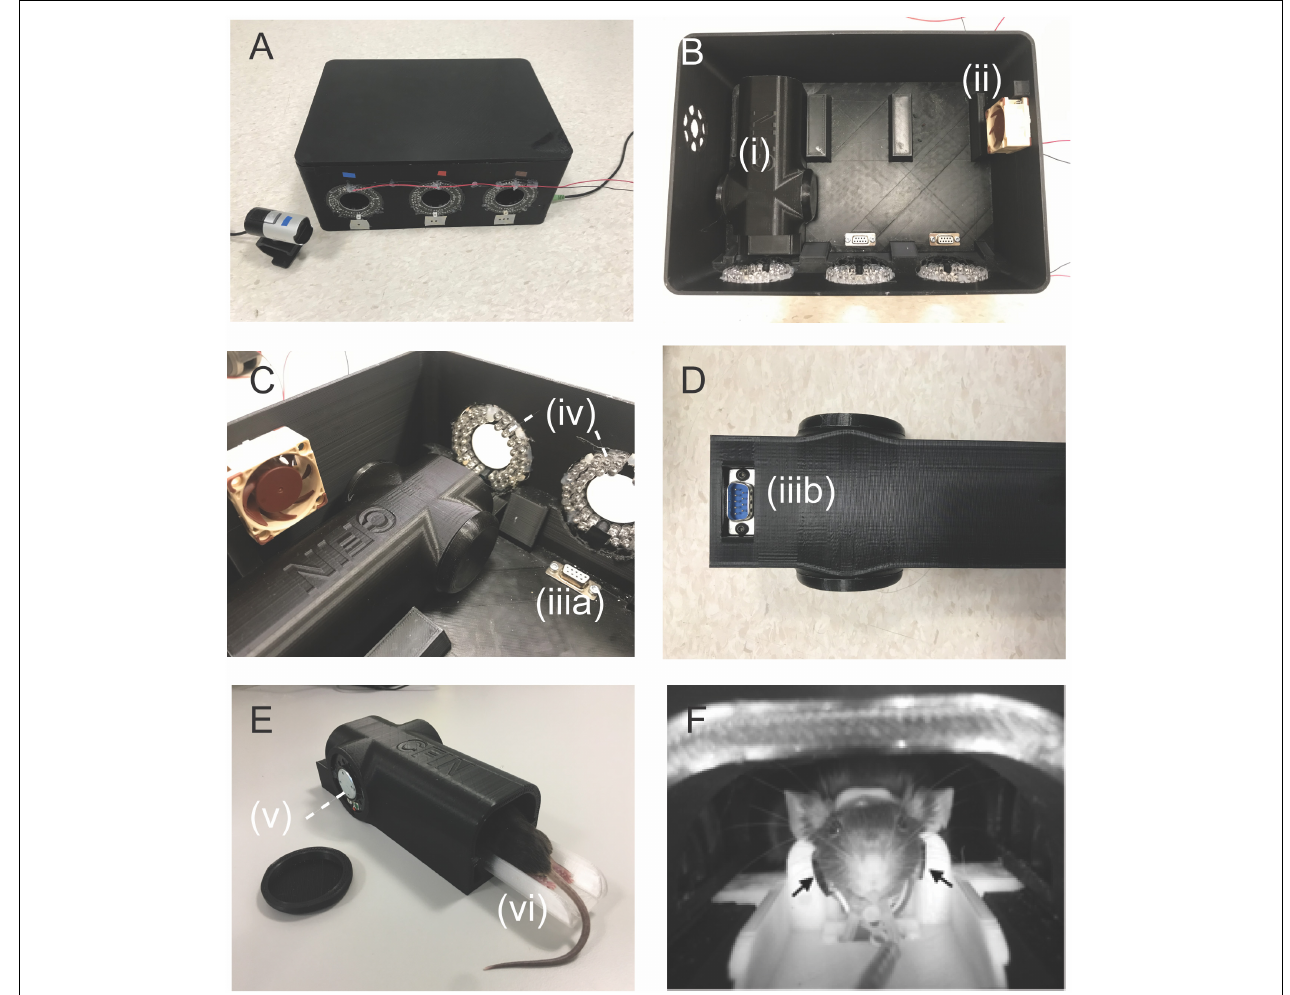
FIGURE 2 | Awake MRI setup and components. (A) Awake MRI habituation box where animals are trained during the awake MRI habituation sessions. (B) Overview of the inside of the habituation box with connections for three chambers (i) with one animal inside each. A small fan provided ventilation of the habituation box (ii) positioned at the side of the box. (C) Sideview of inside the habituation box. The chambers were connected to the audio sockets ( C ,iii) positioned at the bottom of the box. IR diodes provided illumination of the animals for video recordings. (D) Underneath the chamber. Each mock coil had an audio connector ( D ,iii) connected to ( C ,iii). (E) Sideview of the mock MRI coil. The animal bed (iv) was inserted into the chamber (i), and each chamber had speakers installed (v) at the left and right ear of the mouse. (F) Webcam recording of the restrained animal on the MRI bed inside the habituation box. Black arrows: placement of the light sensor (carotid